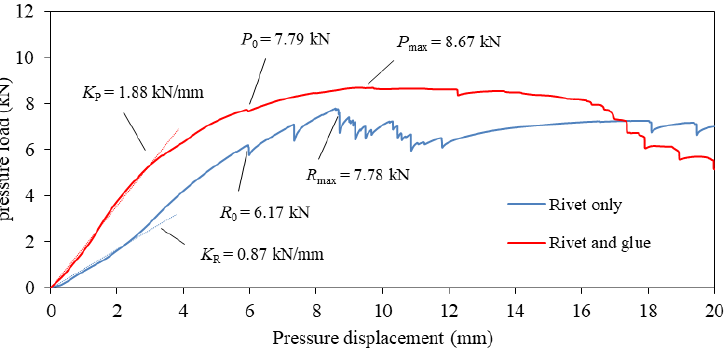
Figure 14. Three-point bending test results of assembled truss core panels joined by different meth-ods.